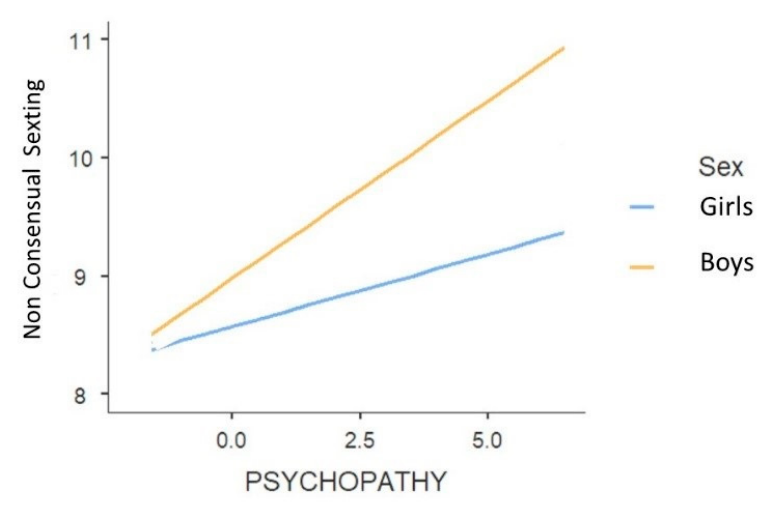
Figure 2. The effect of psychopathy on non-consensual sexting in function of biological sex.